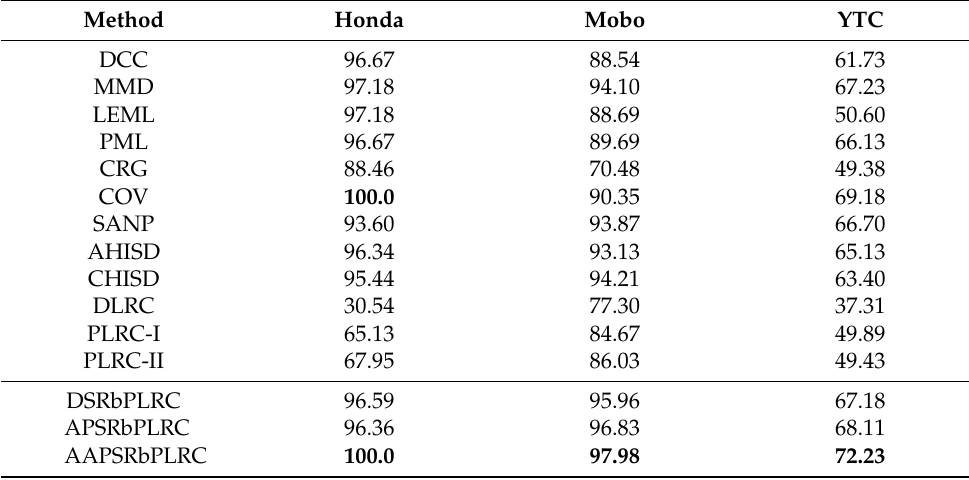
Table 1. The average classification accuracies of the different methods on the three popular databases (%), where the bold denotes the best